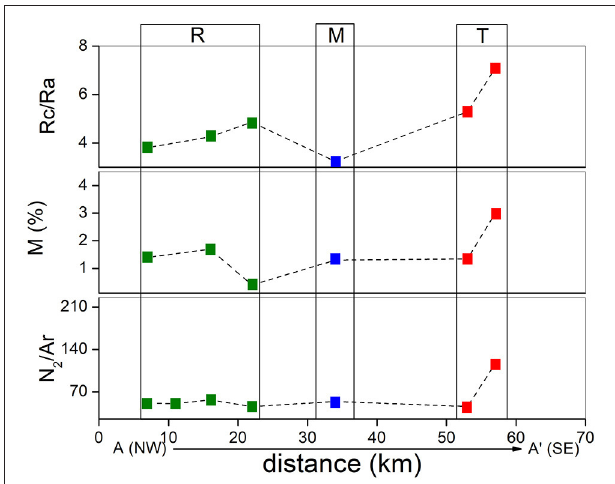
FIGURE 6 | Schematic draft of the spatial distribution of Rc/Ra and N 2 /Ar ratios and mantle CO 2 fraction values (M in %) in hydrothermal fluid discharges from the studied volcanic systems of Guanacaste. Symbols as in Figure 1